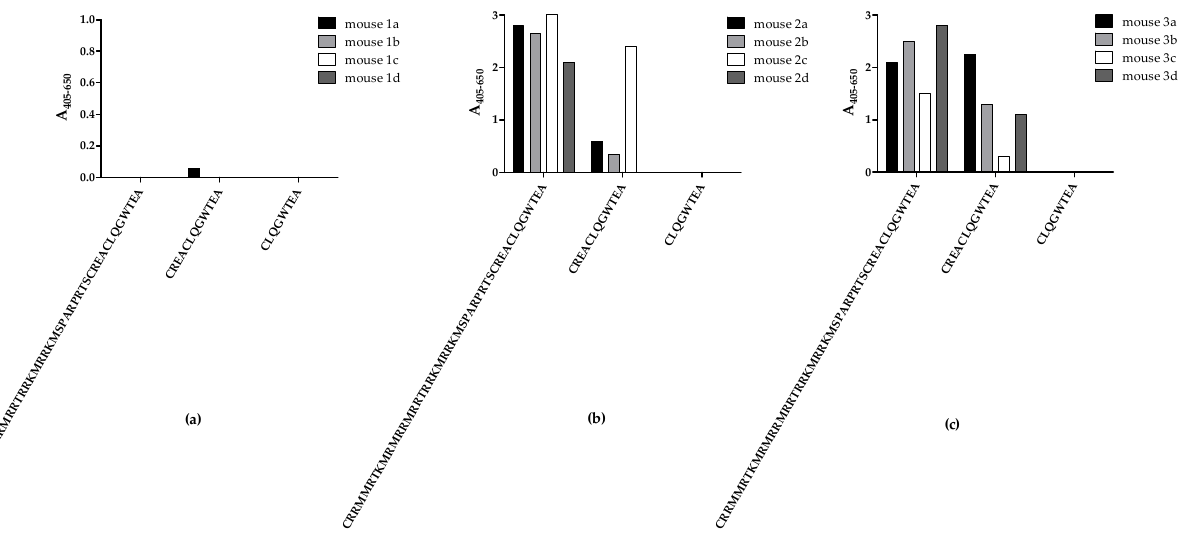
Figure 2. Reactivity of mouse bleeds to peptides used for immunisation tested in enzyme-linked immunosorbent assay. Fourth collection of mouse bleeds were tested for antibody reactivity to peptides 1–3: ( a ) Four mice (1a–d) were immunised with peptide 1 (CRRMMRTKMRMRRMRRTRRKMRRKMSPARPRTSCREACLQGWTEA), and the collected samples were tested for reactivity to peptides 1–3. ( b ) Four mice (2a–d) were immunised with peptide 2 (CREACLQGWTEA), and bleeds were tested for reactivity to peptides 1–3. ( c ) Four mice (3a–d) were immunised with peptide 3 (CLQGWTEA), and bleeds were tested for reactivity to peptides 1–3. Absorbances were corrected for background reactivity by subtracting reactivity from non-coated